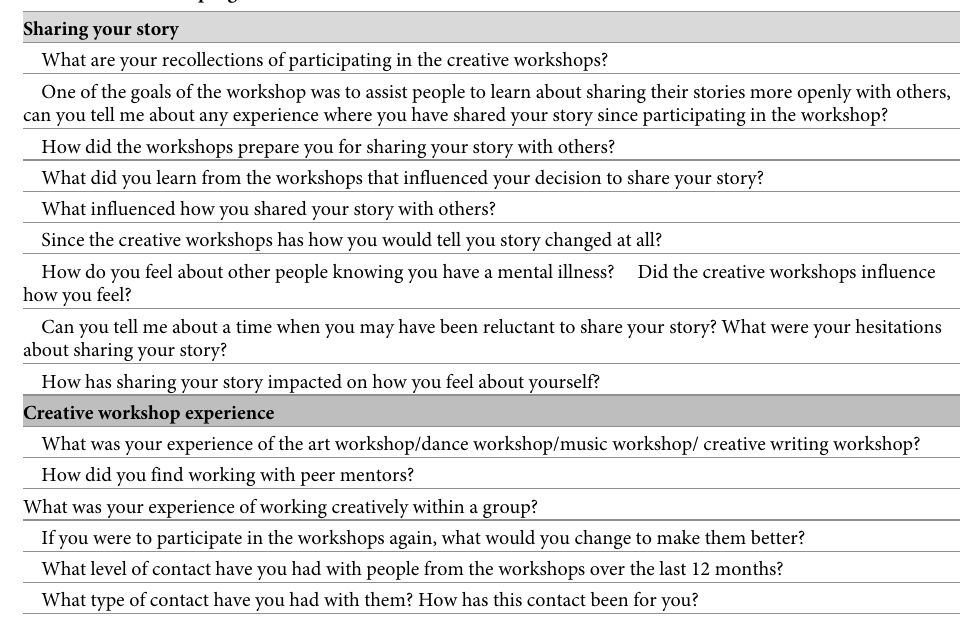
Table 1. Interview topic